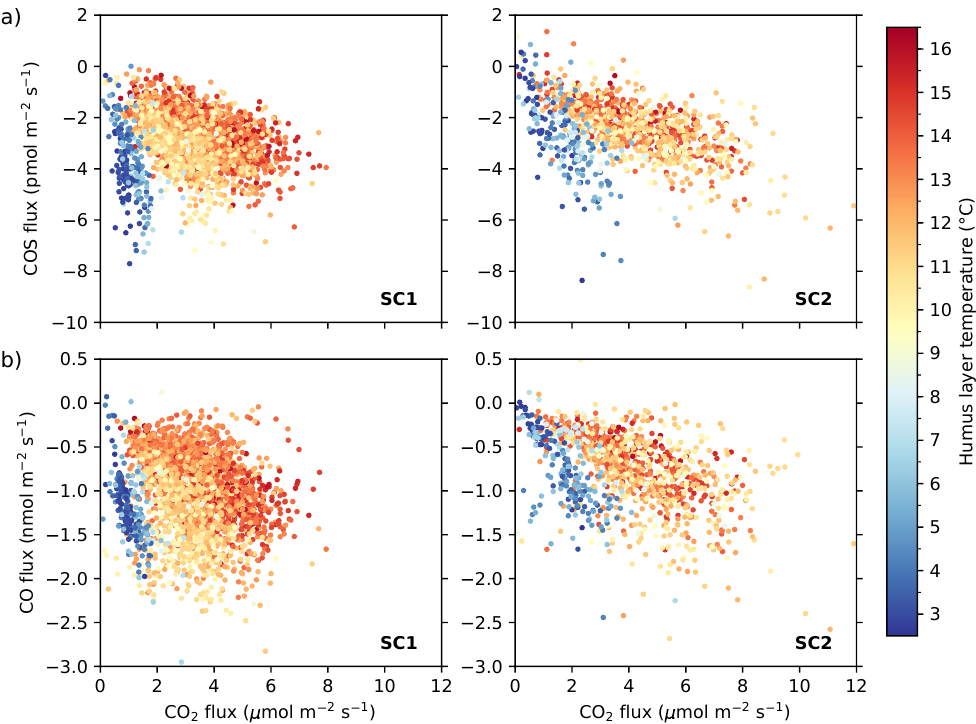
Figure 5. Relationships between COS and CO 2 fluxes (a) and between CO and CO 2 fluxes (b) . The slopes are modulated by soil humus layer temperatures